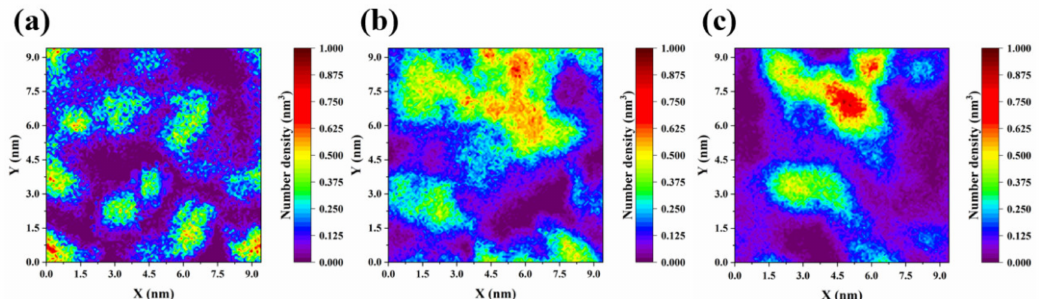
Figure 9. Two-dimensional number density maps of asphaltene distribution in the XY plane at the oil/water interface in the GO-free ( a ), GO ( b ), and JGO ( c )